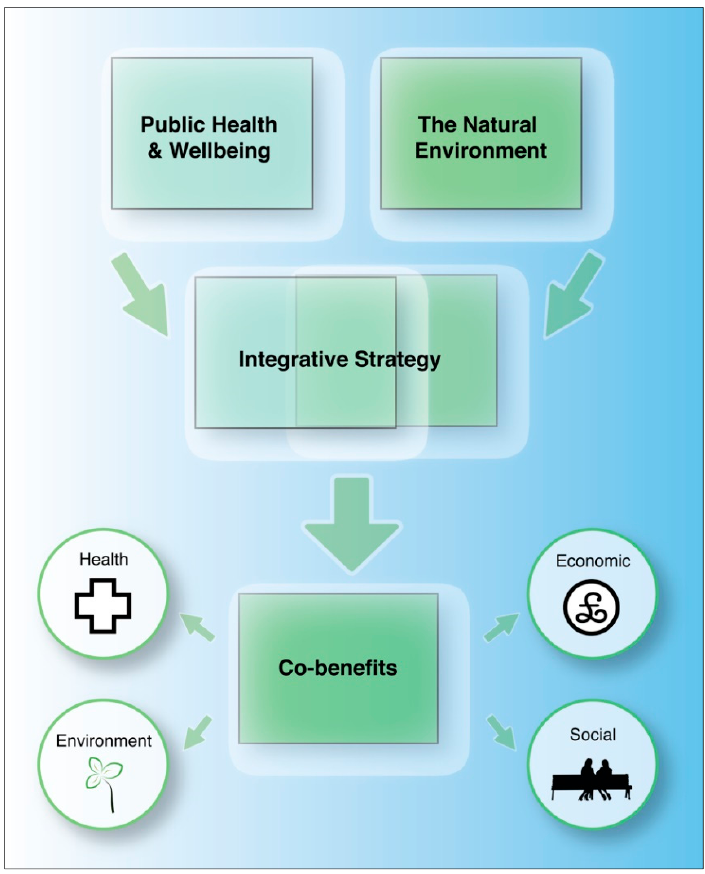
Figure 1. A call for integrative strategies that provide co-benefits for humans and nature (created by the authors). the